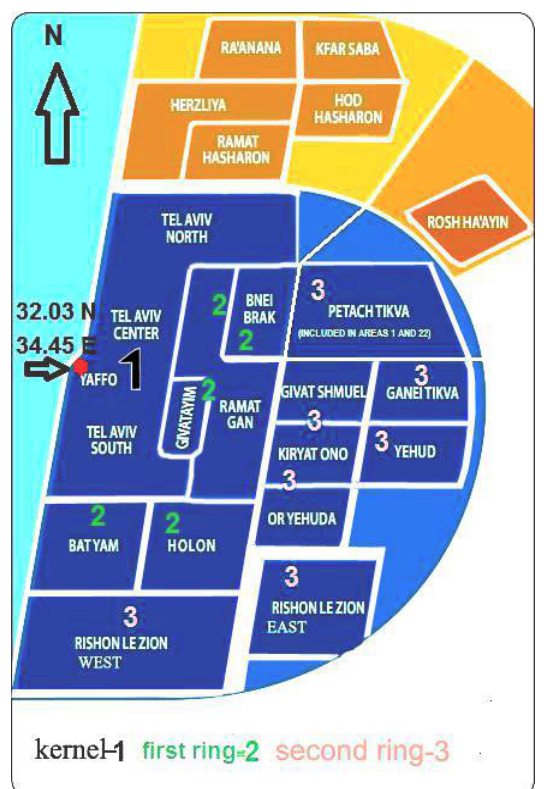
Figure 2. Municipalities of Greater Tel- Aviv area. The kernel zone (denoted 1) is Tel-Aviv-Jaffa (Jaffa Harbor is denoted by the red point at 32.03 N, 34.45 E). First and second rings municipalities are listed in Table 1 and are denoted here by zones 2 and 3, respectively. The other municipalities indicated to the north are not considered part of Greater Tel-Aviv in this study. Table 1. Population of the municipalities of the Greater Tel Aviv area ( “ Gush-Dan ” ) during 1948 –